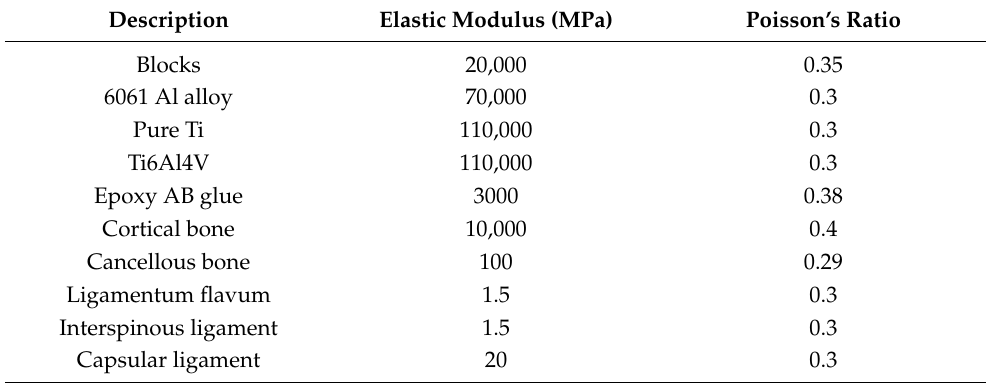
Table 1. Material properties of fatigue-testing fixture and spinal components used in the present